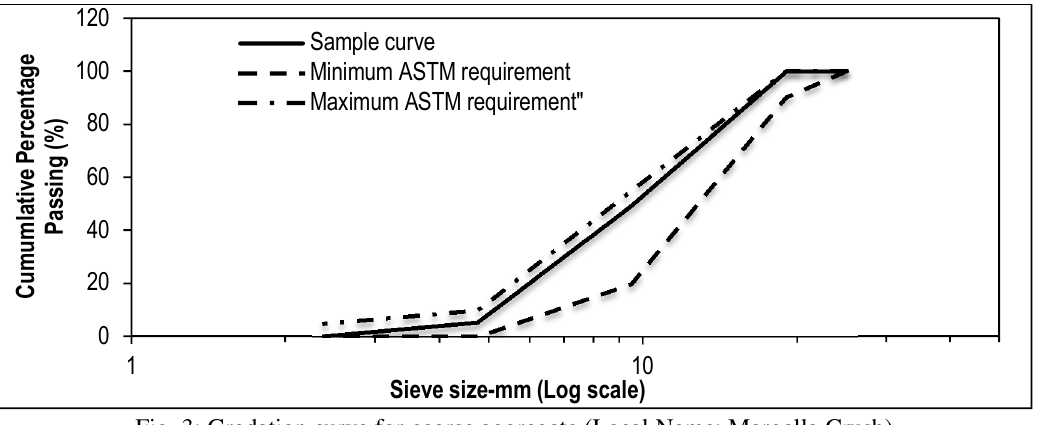
Fig. 3: Gradation curve for coarse aggregate (Local Name: Margalla